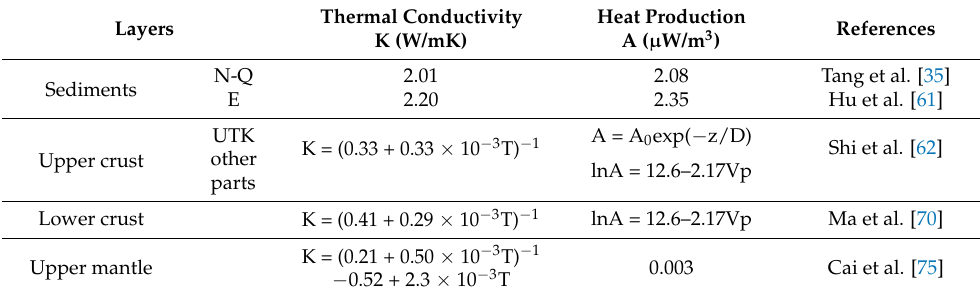
Table 1. Lithospheric thermophysical parameters used in calculations of temperature